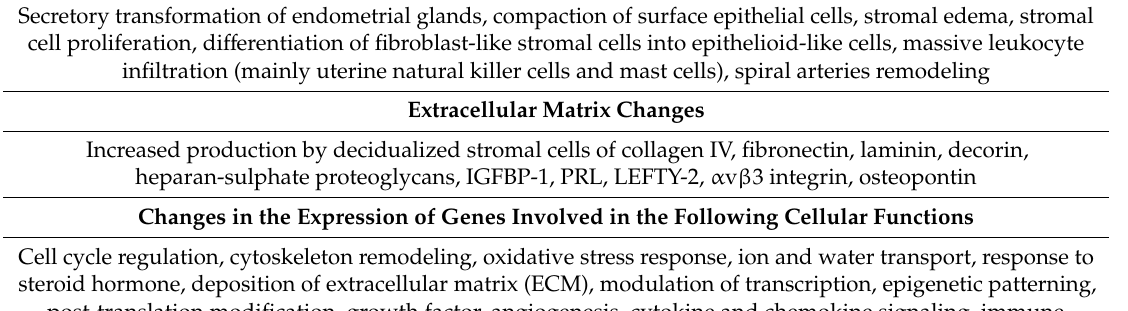
Table 1. Simplified summary of the major changes characterizing the decidualization of the endometrium. Morphological (Tissutal and Cell)